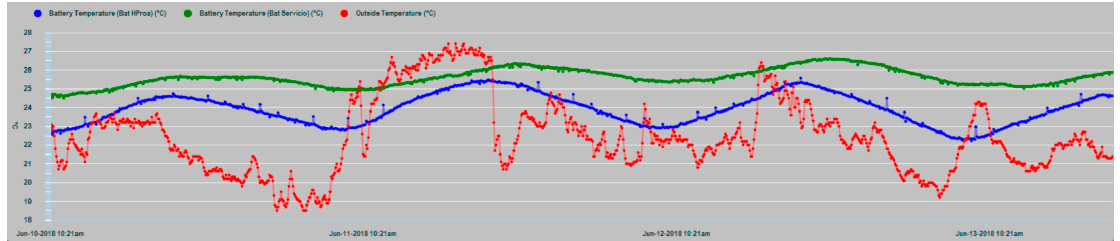
Figure 14. Time series of the outside temperature T ex (red) and the internal temperatures T in of bow thruster battery bank (blue) and house battery bank (green).